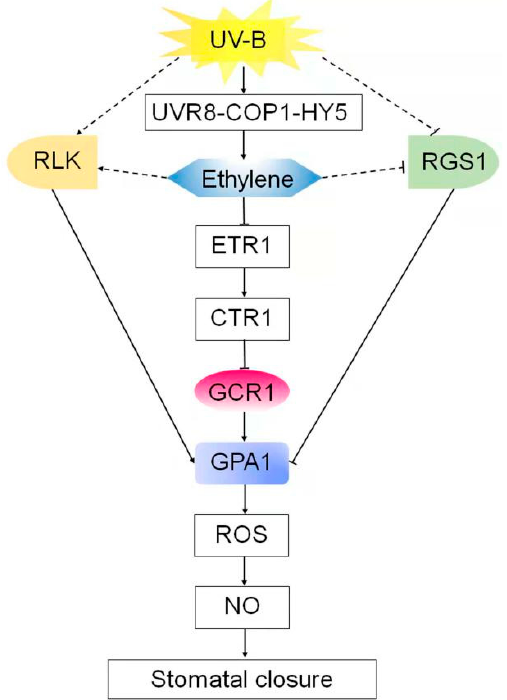
Figure 8. Modules showing the possible signaling pathways for UV-B- and ethylene-induced stomata closing. UV-B signaling in guard cells is initiated by the UV-B-specific signaling pathway UVR8-COP1-HY5 via induction of ethylene production. Ethylene is perceived by its receptor, ETR1, to inactivate the CTR1 kinase, releasing GCR1-dependent GPA1 activation. Then activated, GPA1 induces ROS and NO generation in guard cells and subsequent stomata closing. UV-B and ethylene maybe also activate GPA1 by inducing receptor-like kinases (RLKs)-phosphorylated GPA1 or by inhibiting RGS1-dependent deactivation of GPA1. Arrows and bars indicate induction and inhibition, respectively. The dashed line indicates a hypothetical cell response.